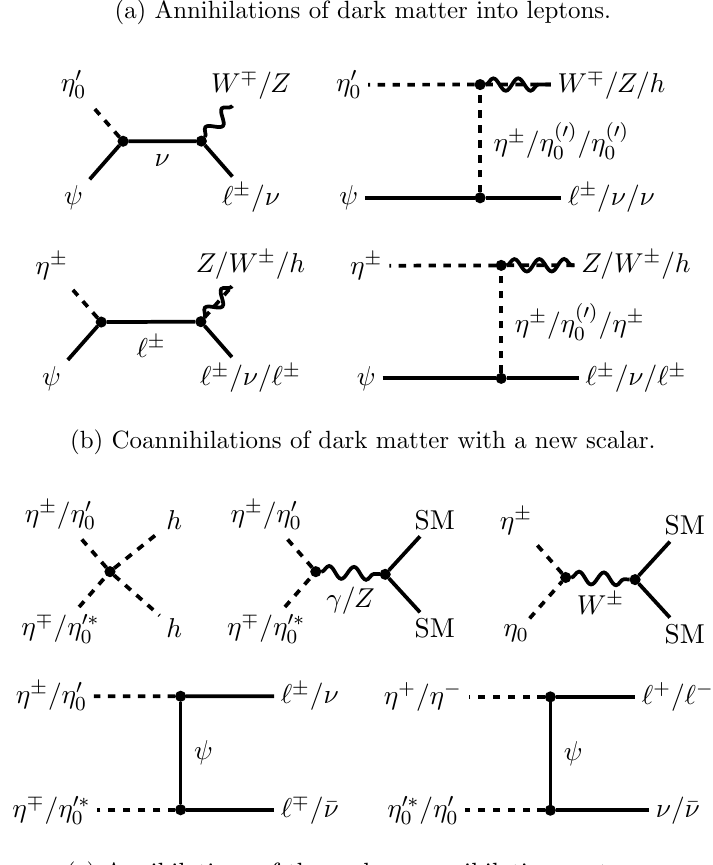
Figure 5 . Illustration of the relevant annihilation (top panel) and coannihilation (middle panel) channels of the dark matter involving the scalars (cid:17) (cid:6) ; (cid:17) 0 tion channels of the coannihilating partners (cid:17) (cid:6) ; (cid:17) 0 the other new